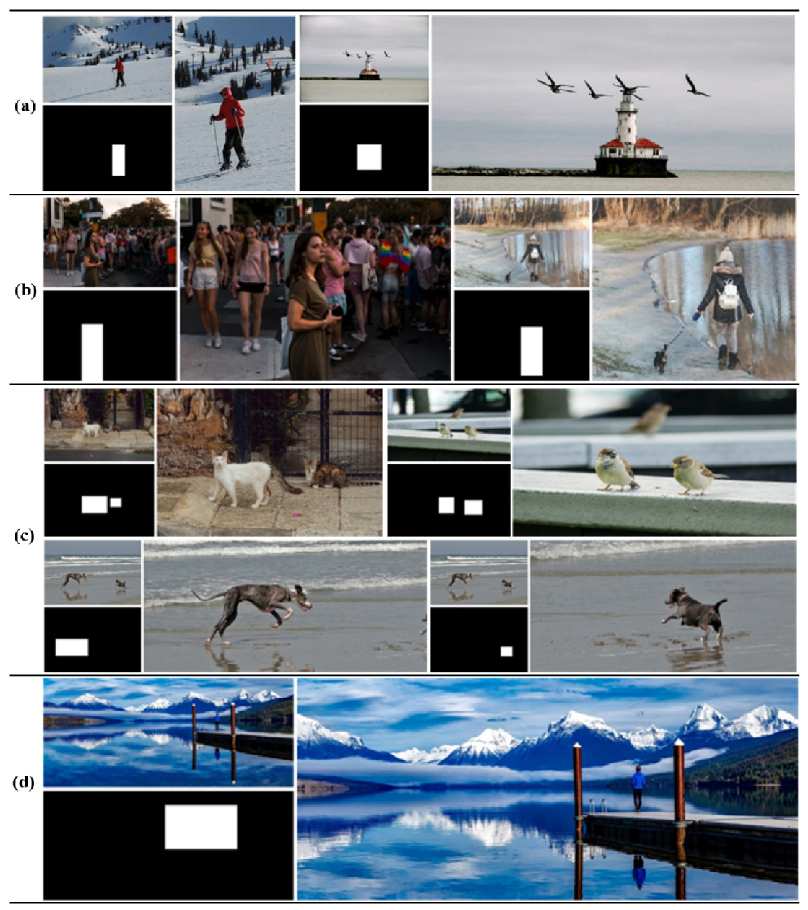
Fig. 14 Further results in different situations. (a, b) Cropping results for a single subject from the SACD dataset and wild images respectively. (c) Results for multiple objects. (d) Results for panoramic